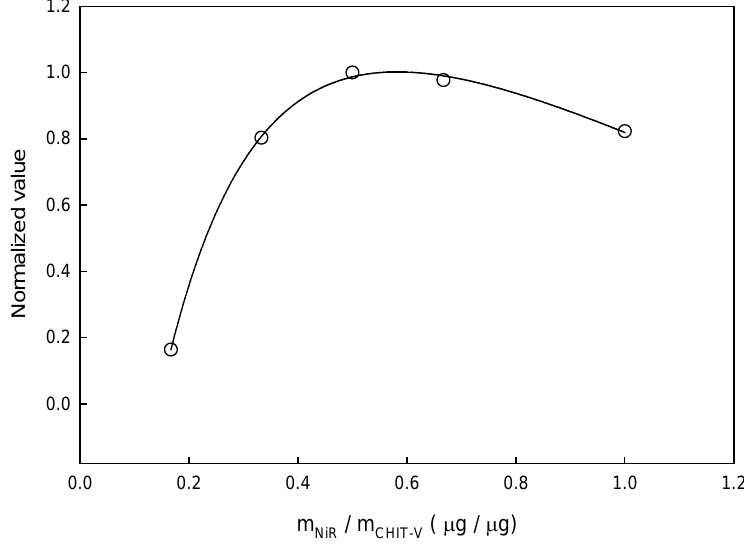
Figure 6. Effect of relative amount of co-immobilized NiR and CHIT-V (m catalytic reduction of nitrite. Catalytic reduction currents for 1 mM nitrite at scan arte of 0.002 V/s were compared. The normalized value was calculated relative to the maximum value of the catalytic